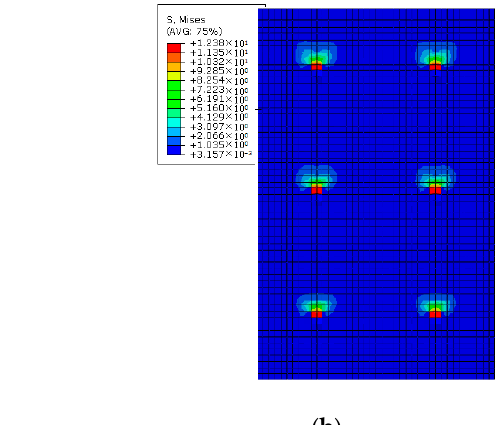
( b ) Figure 16. Stress cloud diagrams of the concrete in the middle wall panel. ( a ) Q1 wallboard; ( b ) Q2 wallboard.